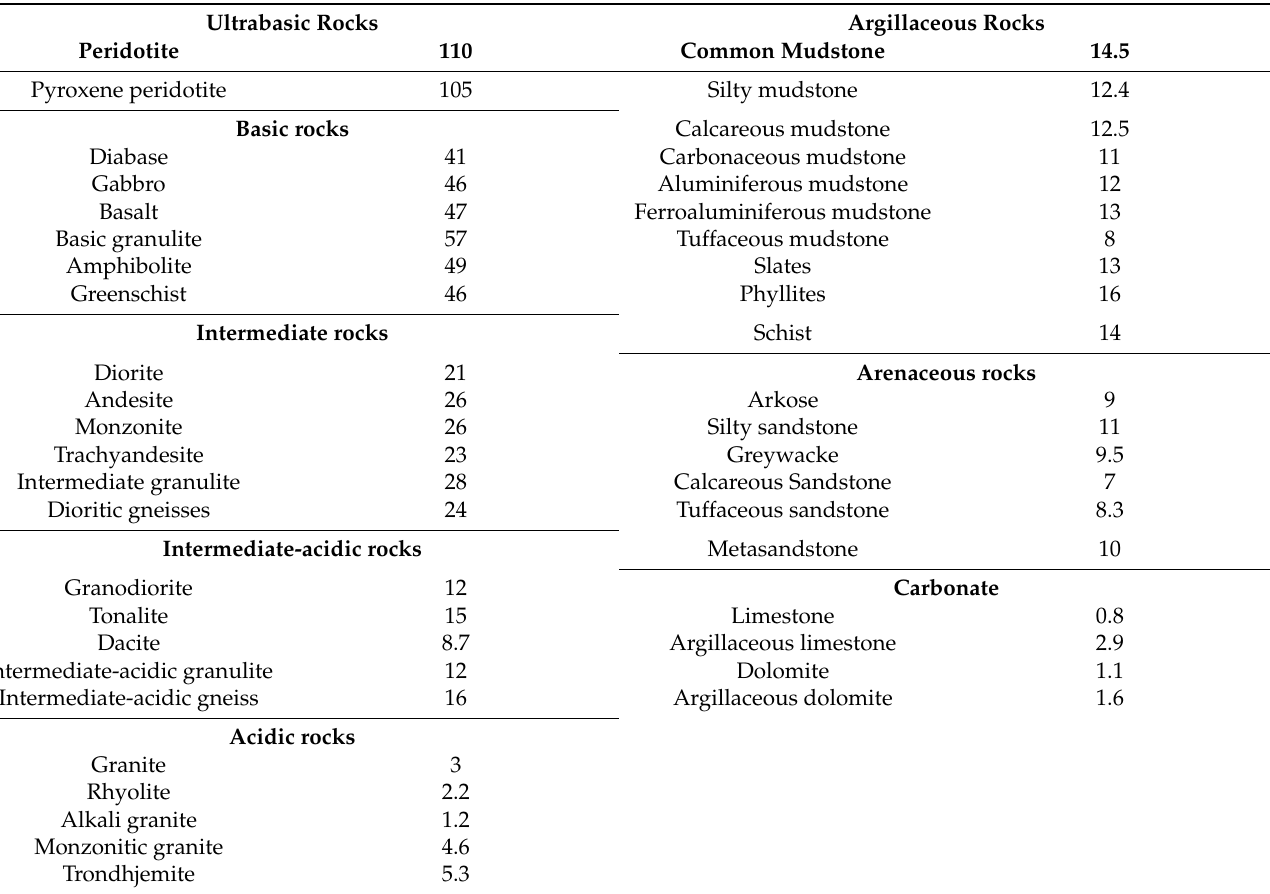
Table 1. Cobalt abundance of different types of rocks (mg/kg). Notation: the cobalt abundance data was quoted from Chi et al.